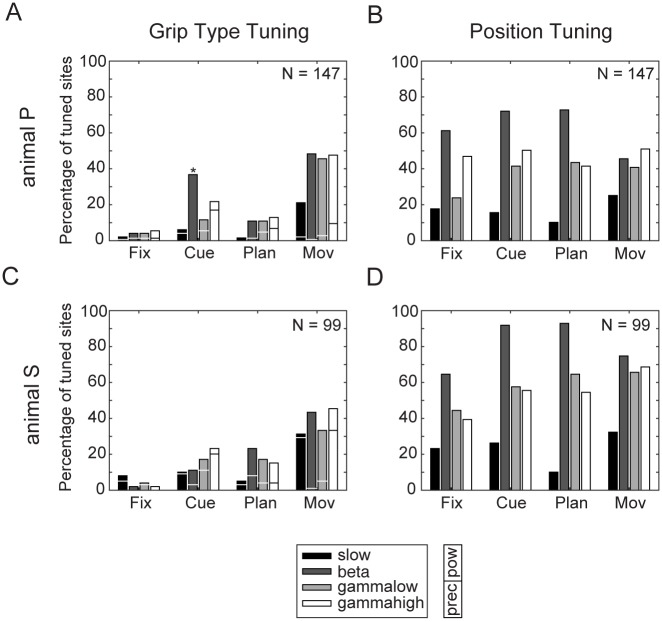
Grip type and position tuning of LFP frequency bands.Percentage of sites tuned (two-way ANOVA, p < 0.05) for the factors grip type (A,C) and position (B,D) for animal P (A,B) and animal S (C,D). Tuning percentages are shown for the slow frequency band (black bars), beta band (dark grey), low gamma band (light grey) and high gamma band (white). Horizontal lines inside bars in A,C indicate fraction of sites tuned for precision (bottom) and power grip (top). Asterisk in Fig 3A indicates preference of 100% for power grip for the beta band during the cue epoch in animal P.